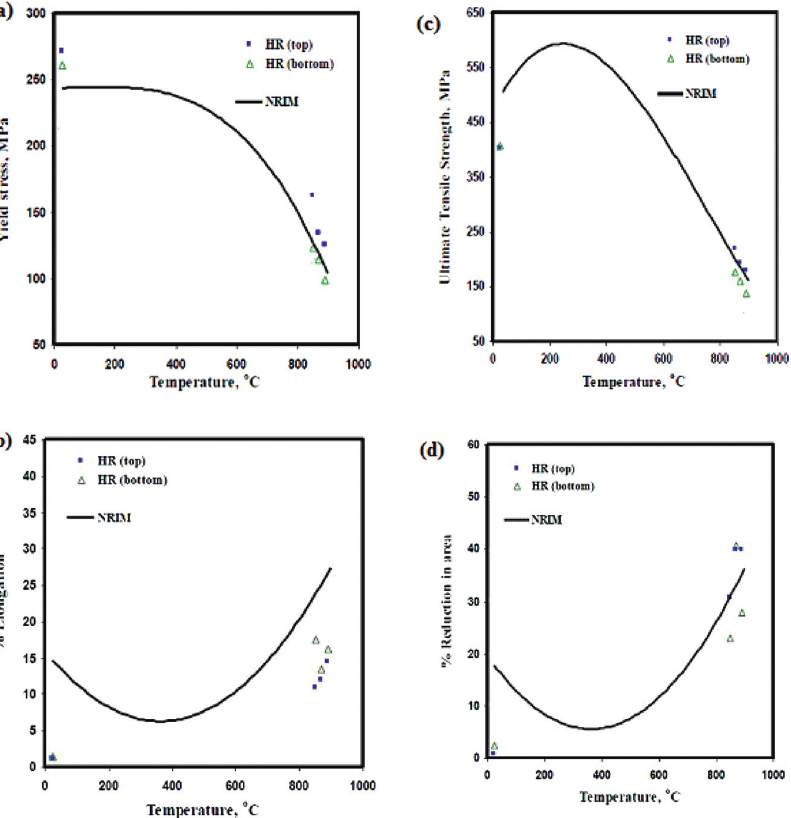
Figure 2: Graphical representation of tensile data of the top and bottom portions of service exposed primary reformer tube as compared with the NRIM virgin data: variation of (a) yield strength, (b) ultimate tensile strength, (c) % elongation and (d) % reduction in area with test temperature.